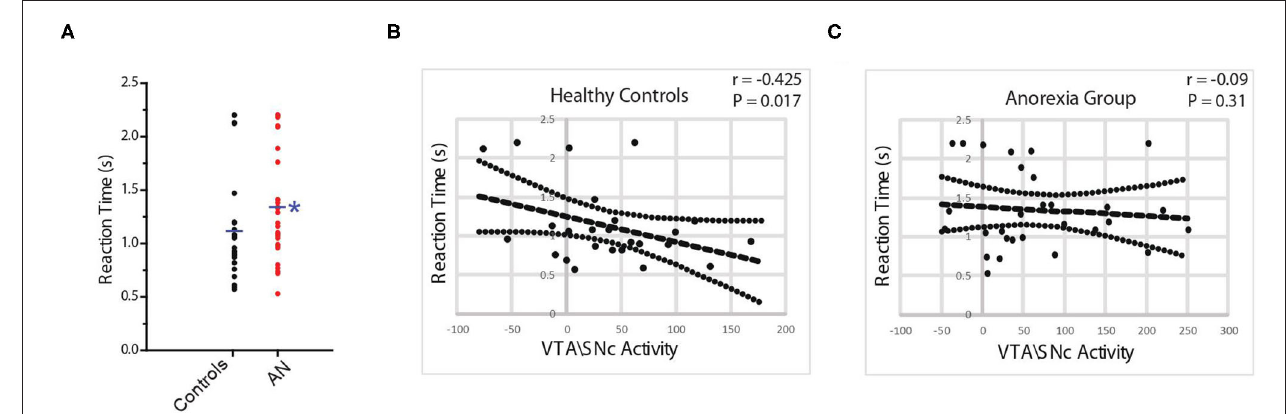
FIGURE 2 | Reaction time (RT) duration is significantly longer in AN participants compared with controls (A) . In controls, there is a significant negative correlation between VTA \ SNc activity and RT duration (B) but not in AN group (C) .